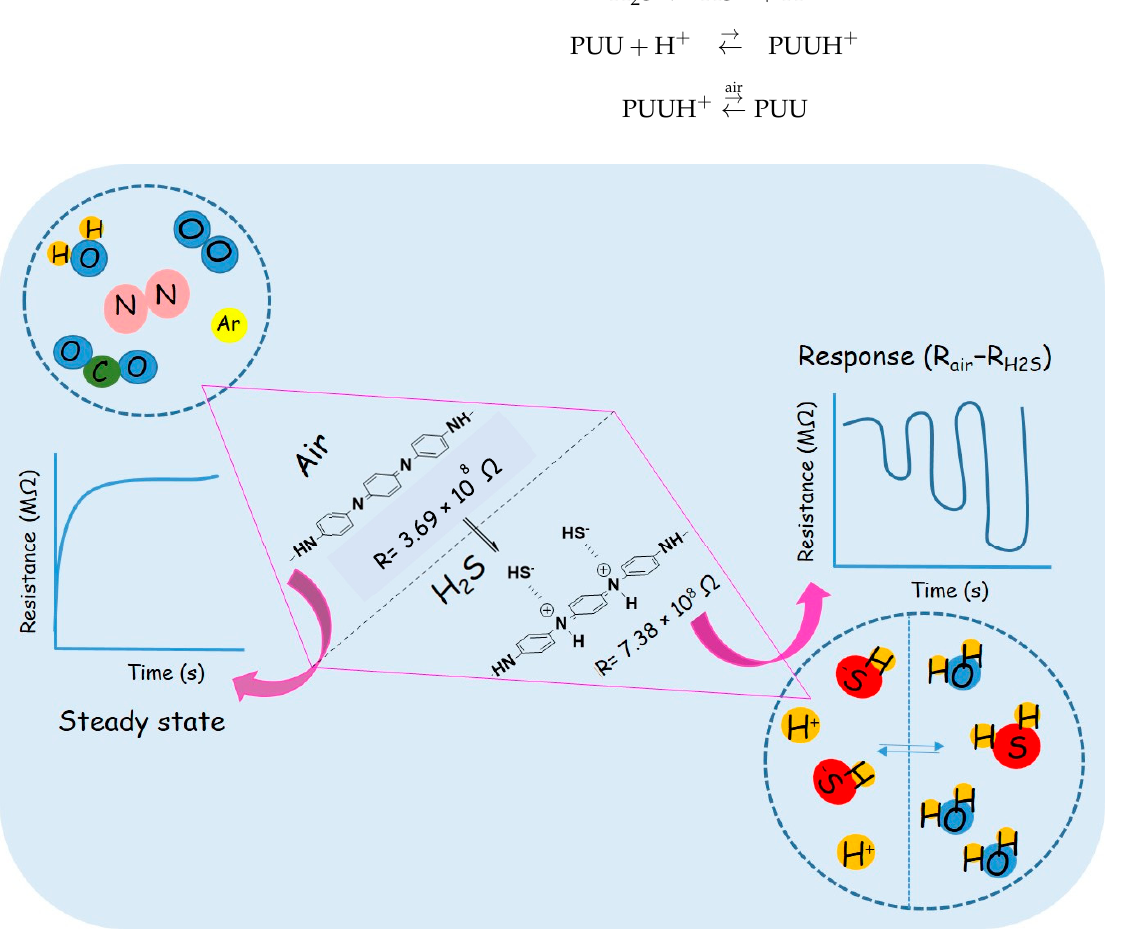
Figure 11. Schematic diagram for H 2 S-gas sensing mechanism by ACAT-based polymer (PUU-AC0) and its composites (PUU-AC1, PUU-AC3).